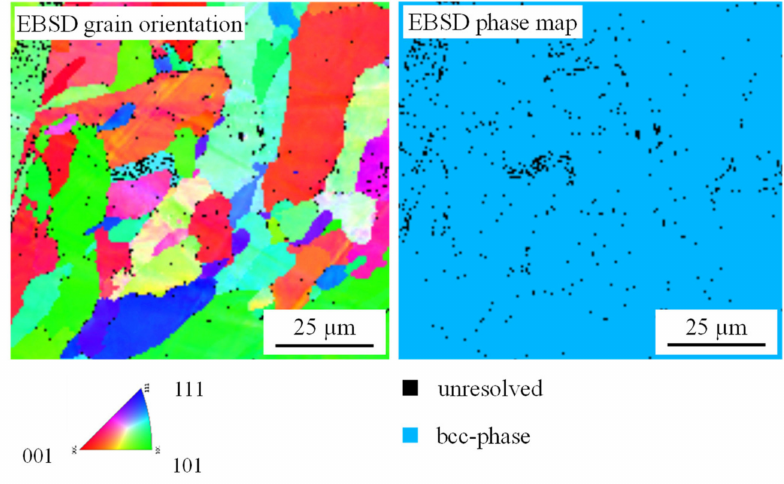
Figure 3. EBSD grain orientation map and EBSD phase map of sample PBF-LB/M